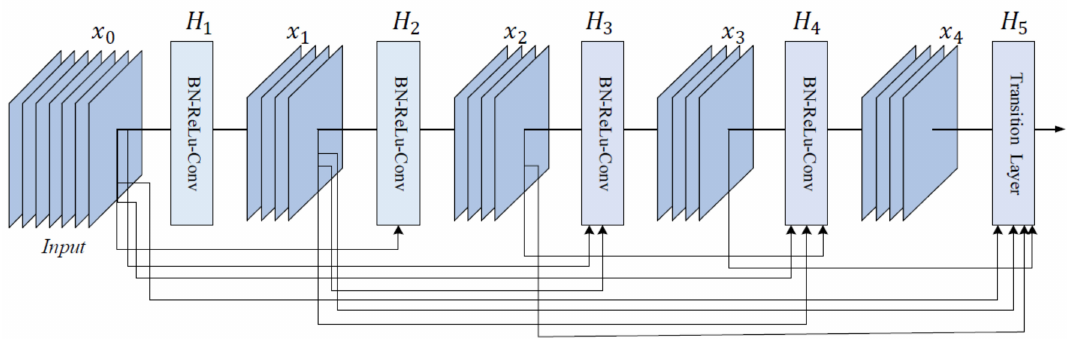
Figure 20. Five-layer DenseNet architecture